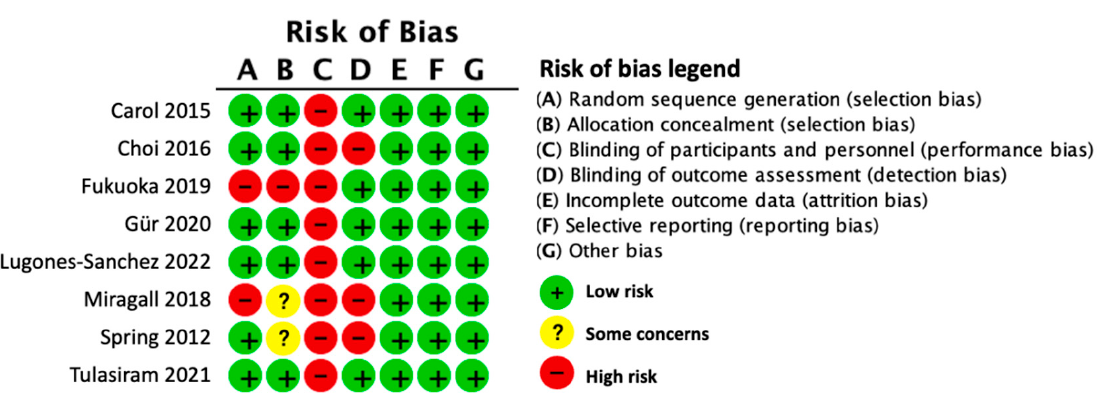
Figure 2 . Risk of bias summary. Figure 2. Risk of bias